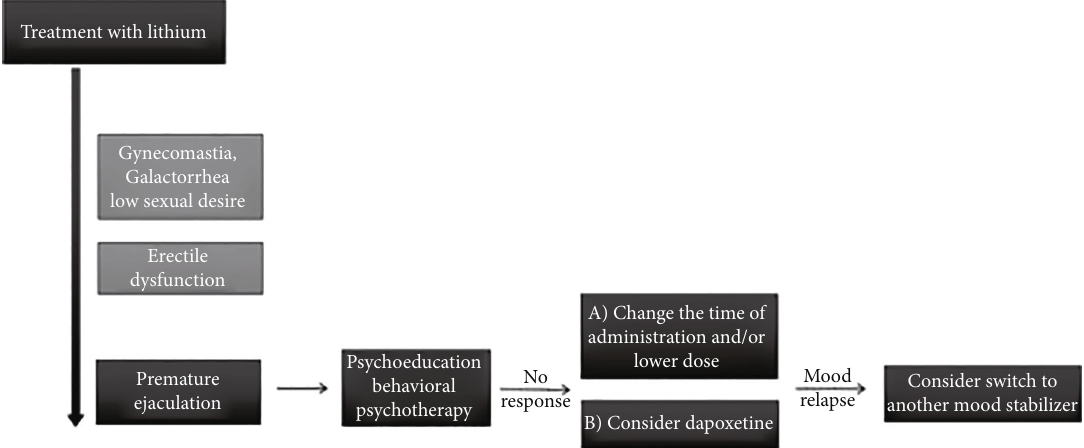
Figure 1: Management of premature ejaculation induced by